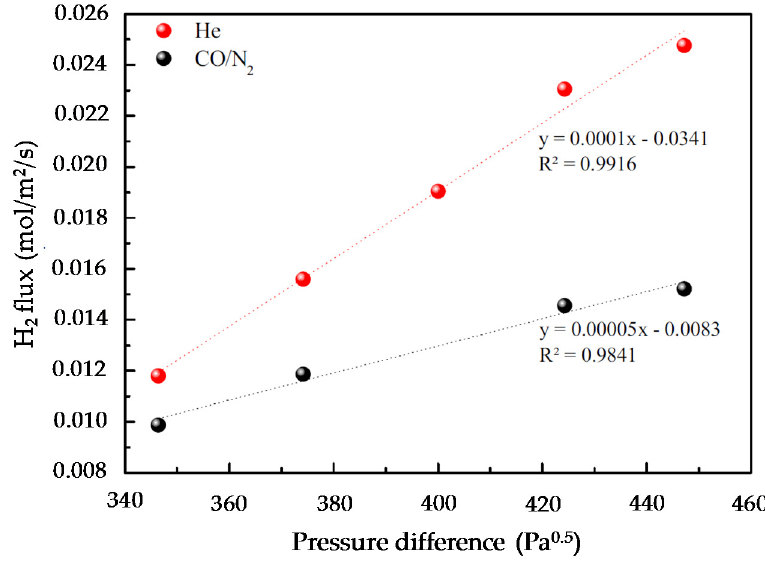
Figure 22. H 2 flux at 280 °C as a function of pressure difference when feeding He (red) or a gas mixture CO/N 2 from inside the membrane [24].